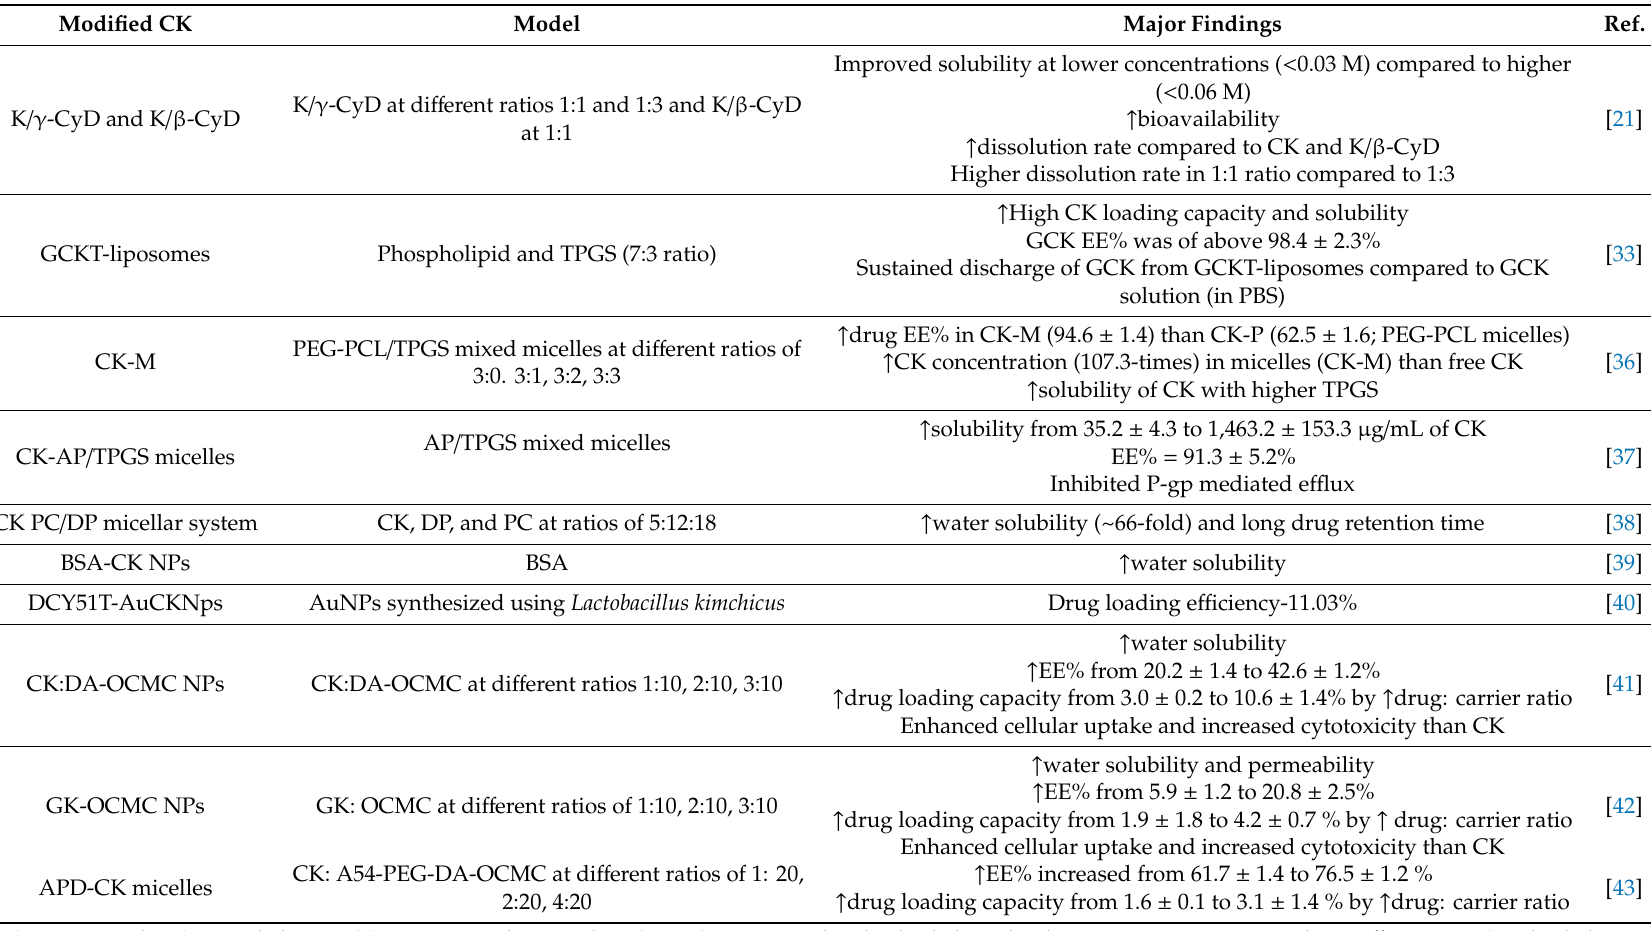
Table 2. Solubility, permeability, and e ffl ux of CK and its